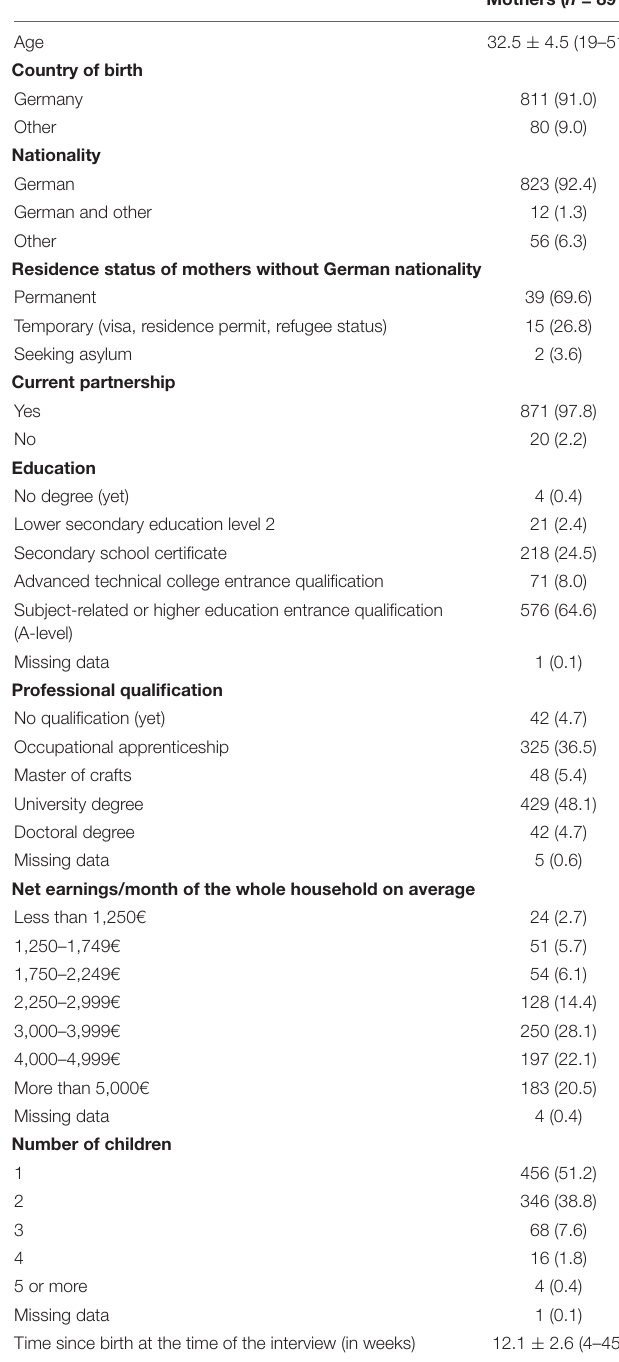
TABLE 3 | Sociodemographic characteristics of the INVITE study